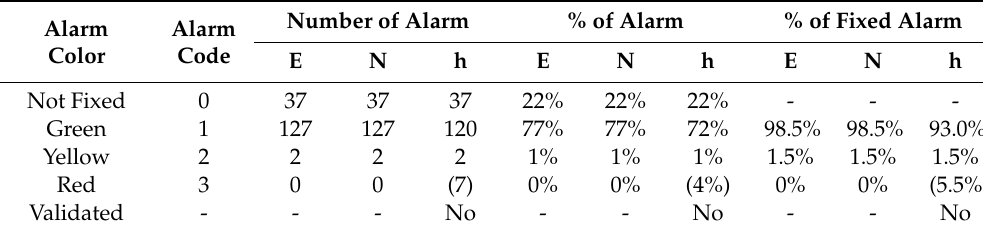
Table 5. The alarm code for East, North, and vertical components the for the period December 2018–May 2019 for the GNSS SAS